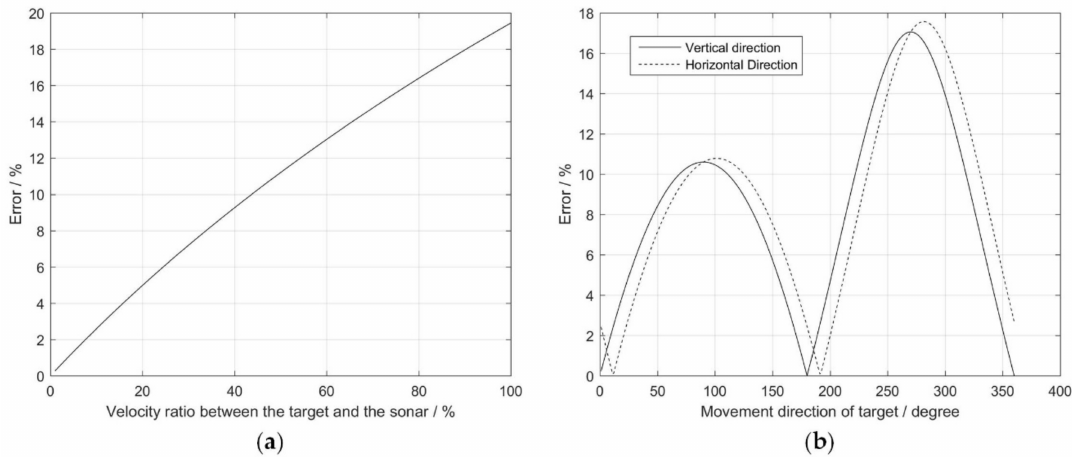
Figure 9. The influence of different factors on the positioning error: ( a ) Velocity ratio between the target and the sonar; and ( b ) target’s moving direction, including vertical direction and horizontal